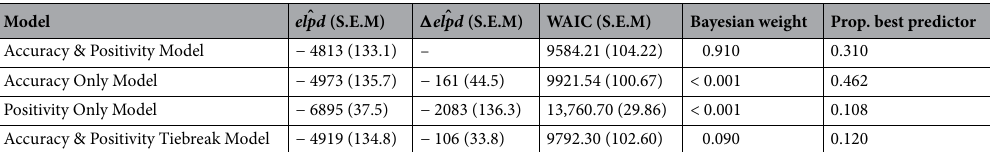
Table 1. Experiment 1 model fit statistics. Estimated expected log-posterior density (elpd), Watanabe–Akaike Information Criterion (WAIC), Bayesian stacking weights, and the proportion of participants whose data was best predicted by each model. Larger positive values of elpd and smaller values of WAIC indicate better predictive performance. The difference from the best fitting model is represented as (cid:31) weights correspond to the weights assigned to the predictions of each model that maximise the log predictive density of future data.